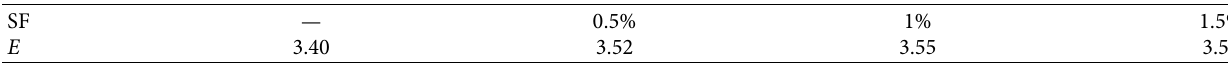
Table 5: Elastic modulus of SFRC at different volume rates ( × 10 4 N/mm 2 ).